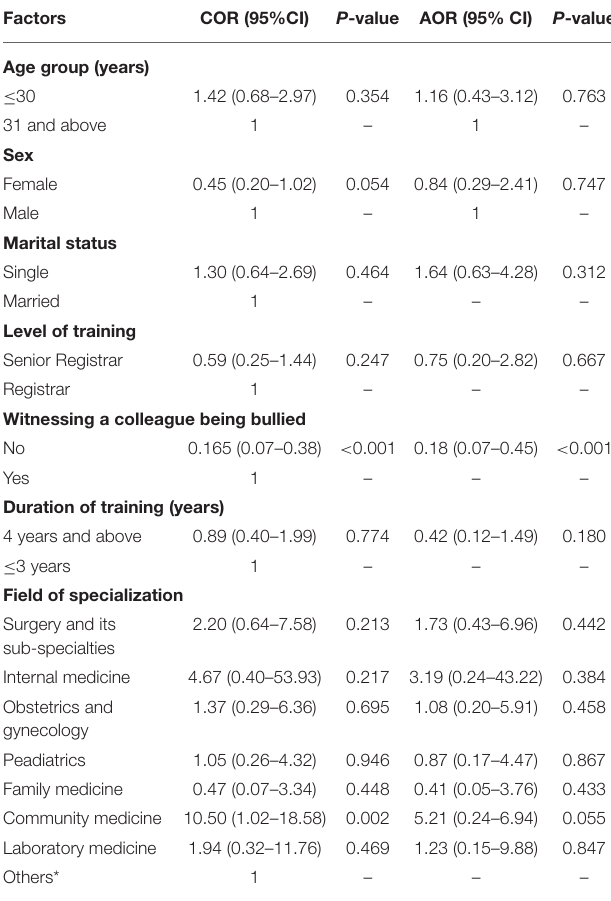
TABLE 3 | Multiple logistic regression of factors influencing workplace